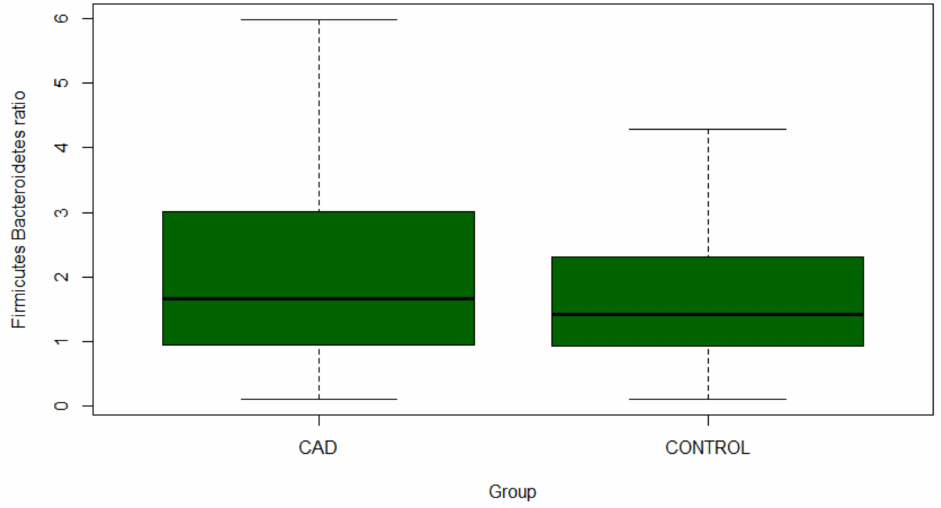
Figure 3. Firmicutes/Bacteroidetes ratio in CAD and control population. CAD—coronary artery